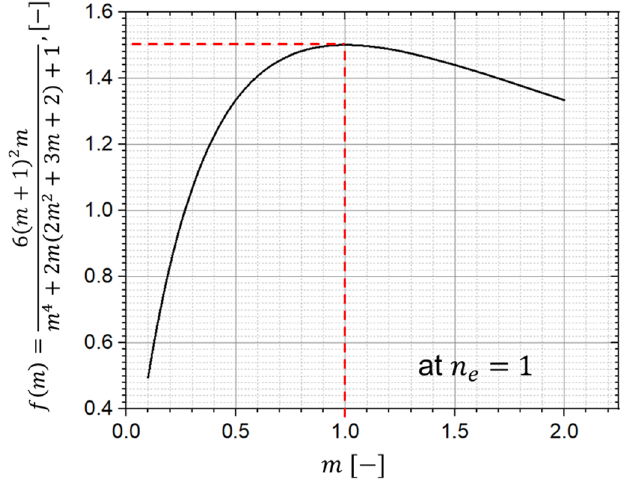
Figure 16. Influence of 𝑚 at 𝑛 (cid:3032) = 1 according to Equation (5).